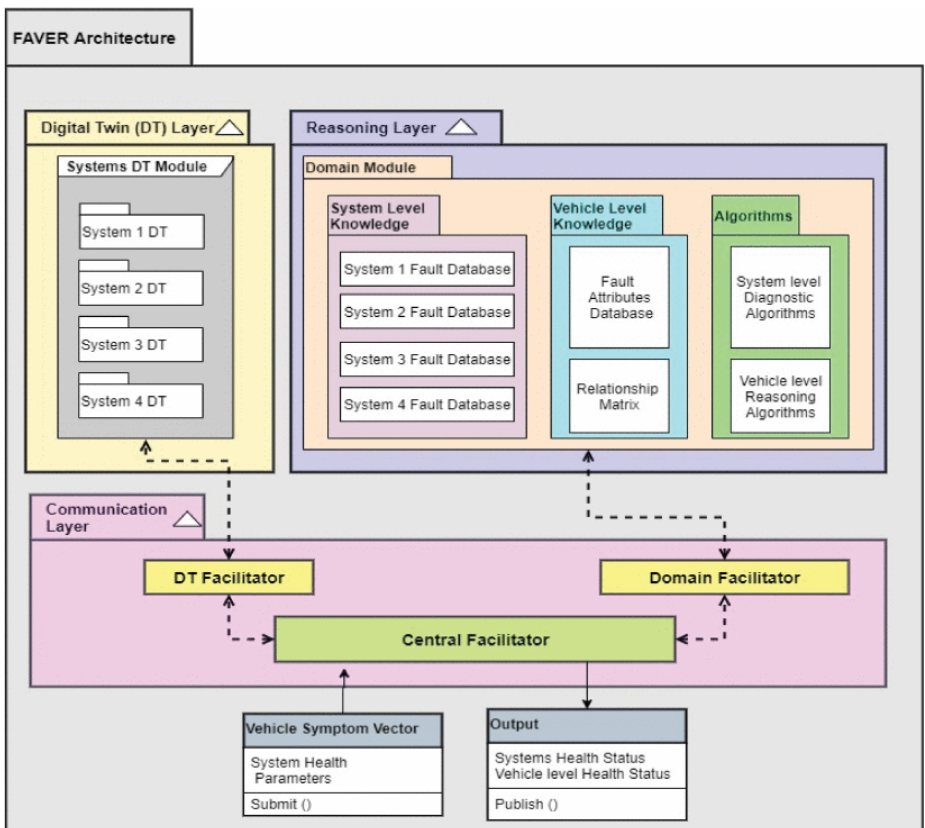
Figure 7. Framework for Aerospace Vehicle Reasoning (FAVER) [43].